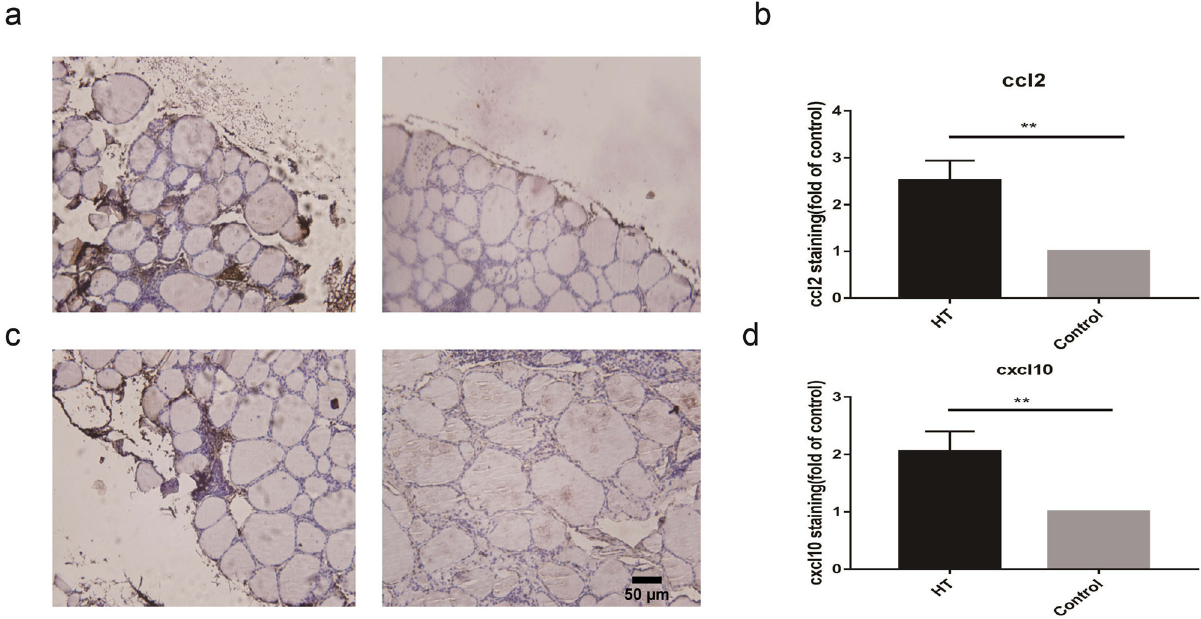
Figure 2: Enhanced expression of CCL2 and CXCL10 in HT patients. ( a ) Immunohistochemistry to detect CCL2 in thyroid gland from HT patients ( n = 6 ) and the control group ( n = 6 ) . ( b ) Histogram of CCL2 protein level. ( c ) Immunohistochemistry to detect CXCL10 in HT patients ( n = 6 ) and the control group ( n = 6 ) . ( d ) Histogram of CXCL10 protein level. ** P < 0.01 vs